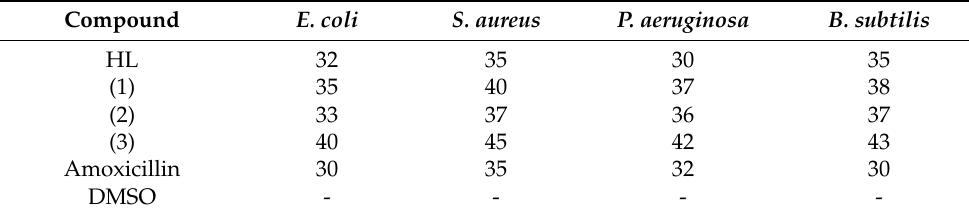
Table 6. The inhibition diameter zone (mm) of the Schiff base and metal complexes against bacte- rial